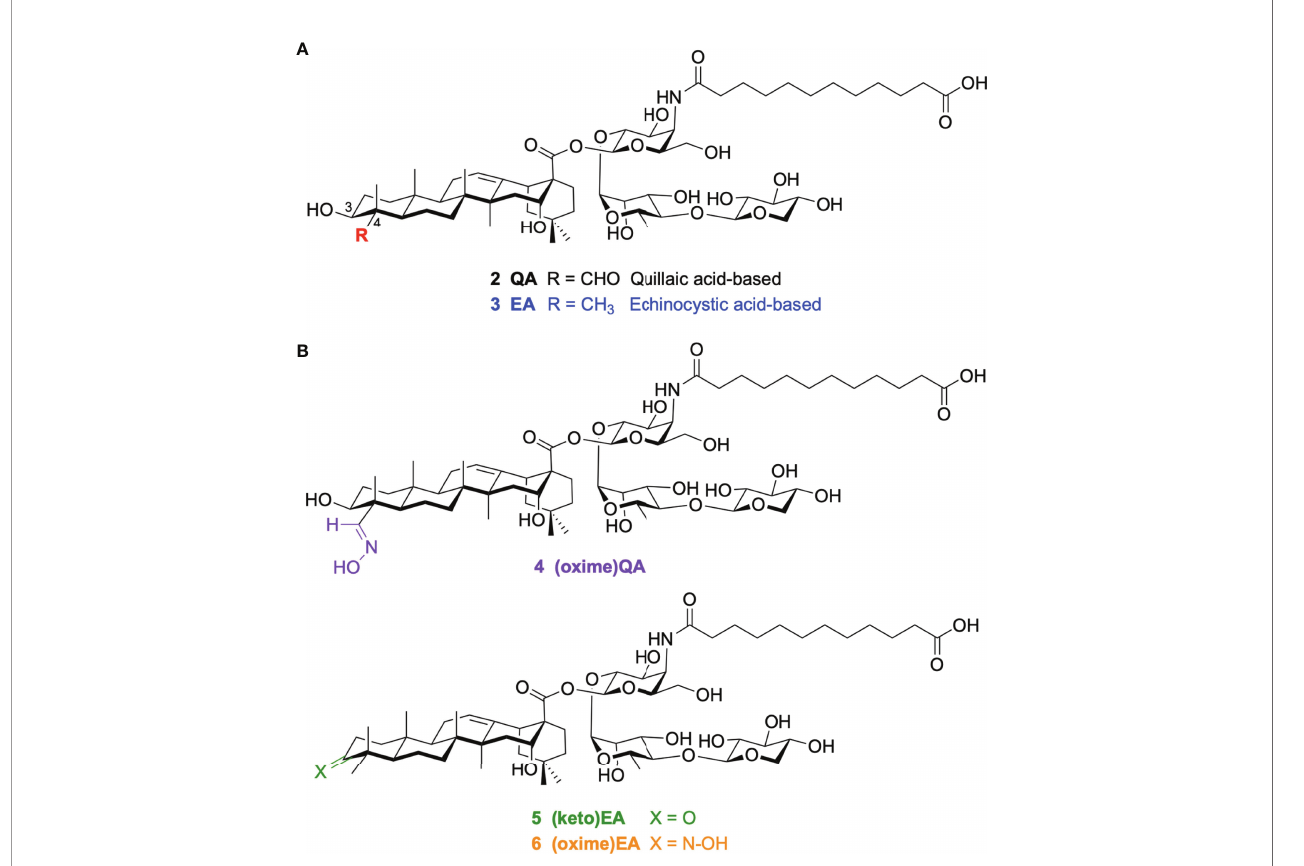
FIGURE 2 | Chemical structure of (A) our previous quillaic acid and echinocystic acid-based saponin lead compounds: 2 QA and 3 EA; and (B) our novel saponin variants 4 – 6 discovered in this